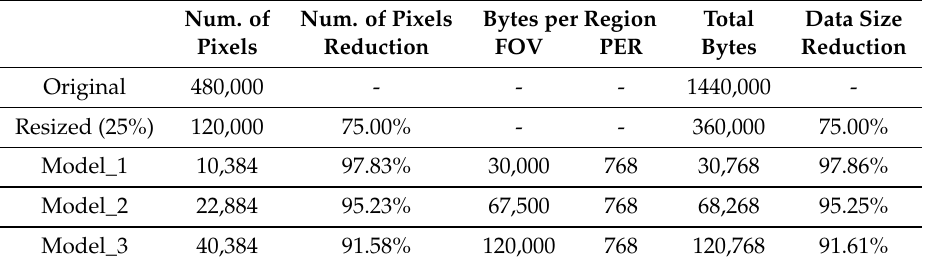
Table 2. Number of pixels and data size reduction results for the evaluated models relative to the original and uniformly resized images (to 25% of their original sizes). Num.